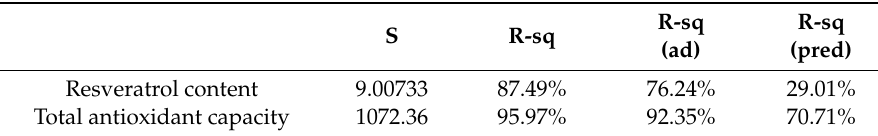
Table 4. Model Table 4. Model Summary.